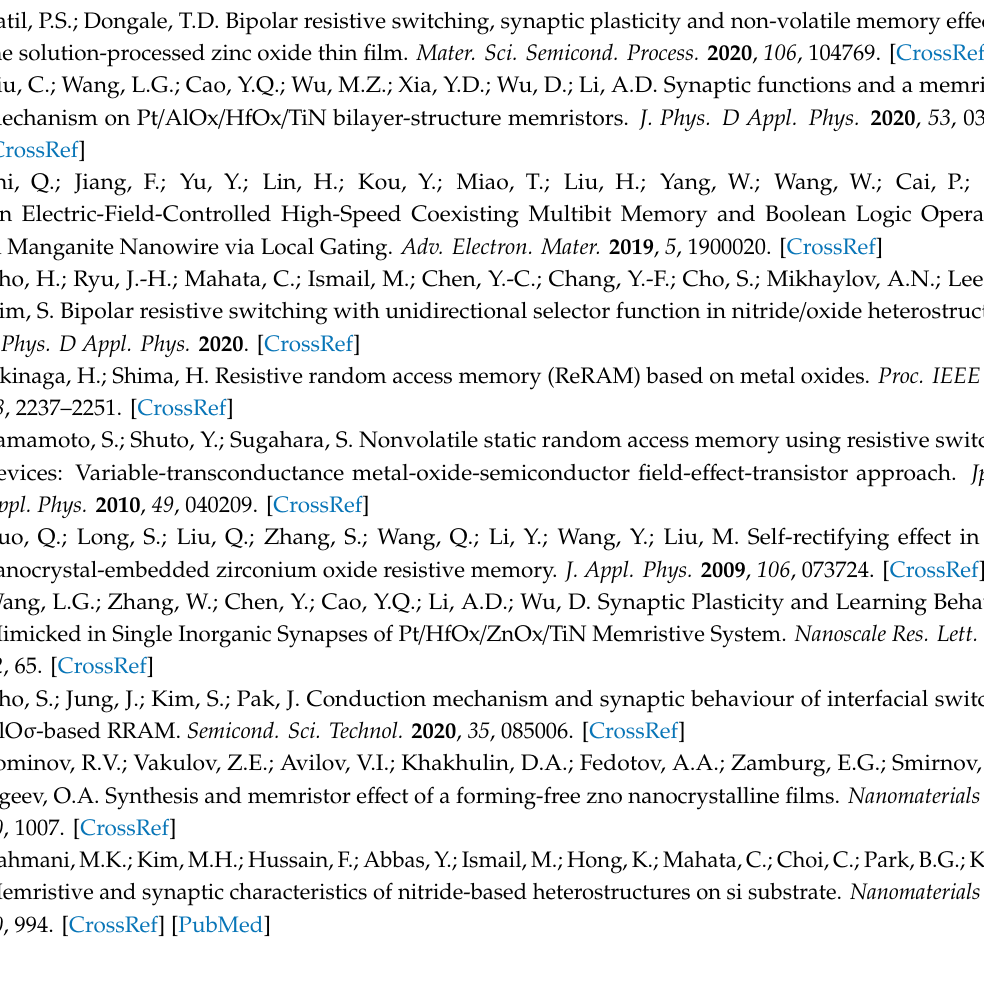
Figure S1: Rectifying I-V characteristics of the TaO x / HfO 2 memristor in the LRS, Figure S2: Retention test for interface-type switching of the TaO x / HfO 2